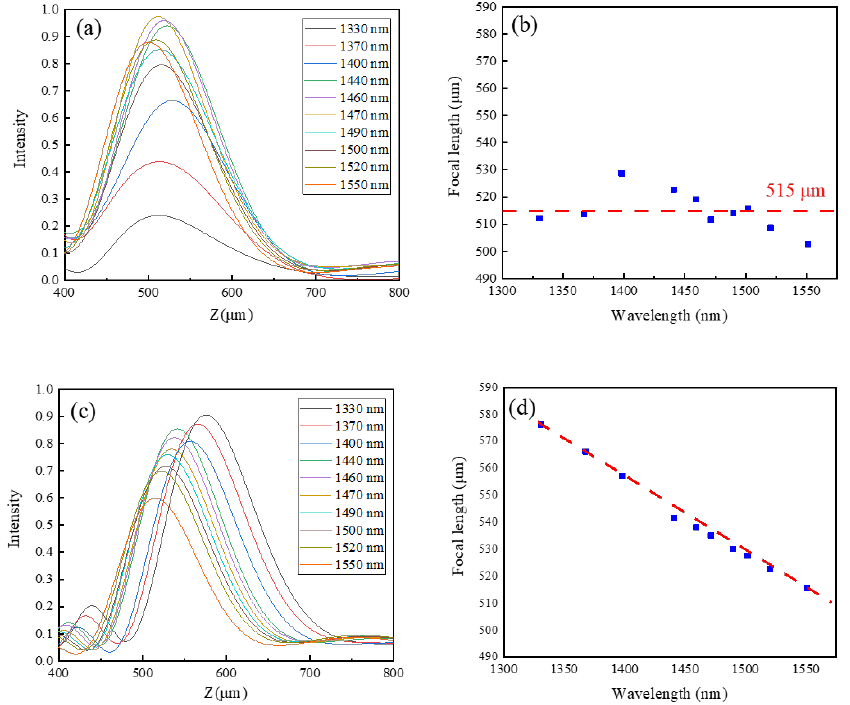
Figure 5. The simulation results. ( a ) the light intensity patterns and ( b ) the focal length of achromatic metalens with different wavelengths; ( c ) the light intensity patterns and ( d ) the focal length of chromatic metalens with different wavelengths.